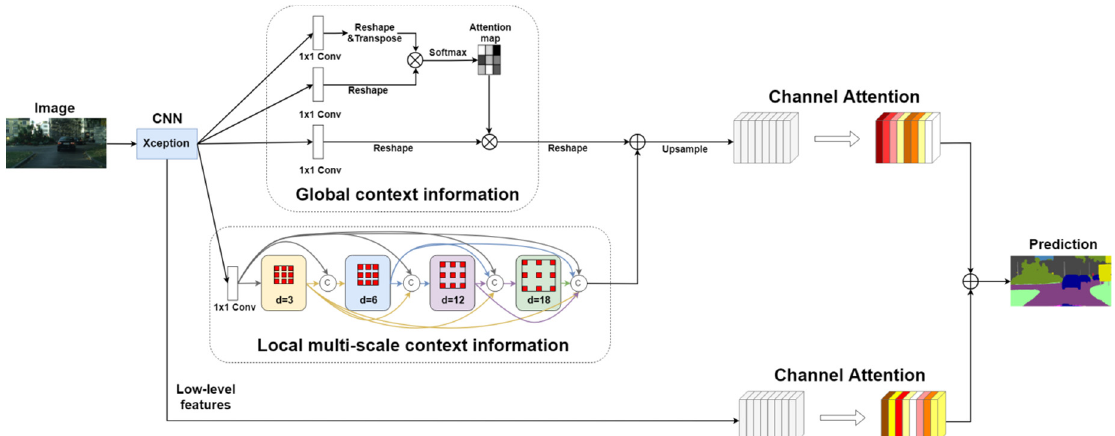
Figure 2. An overview of the proposed GLNet. First, a CNN is applied on the input image and the feature map from the last convolution layer of CNN is kept. Next, global module and local module are deployed on the feature map to capture both global and multi-scale context information. Finally, the channel attention module restores edges and fine details of the segmented objects using low-level features.